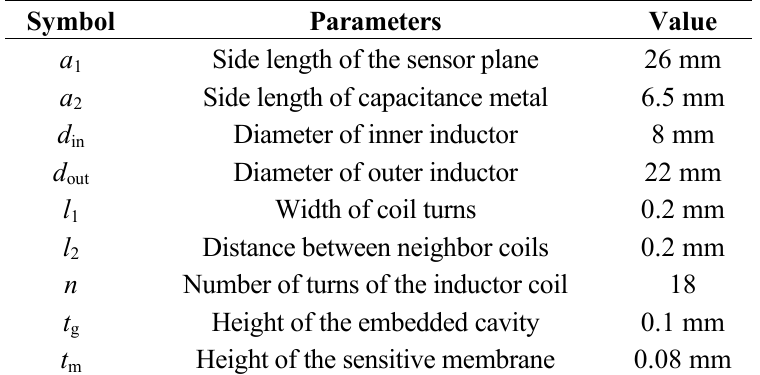
Table 1. Parameters of the sensor